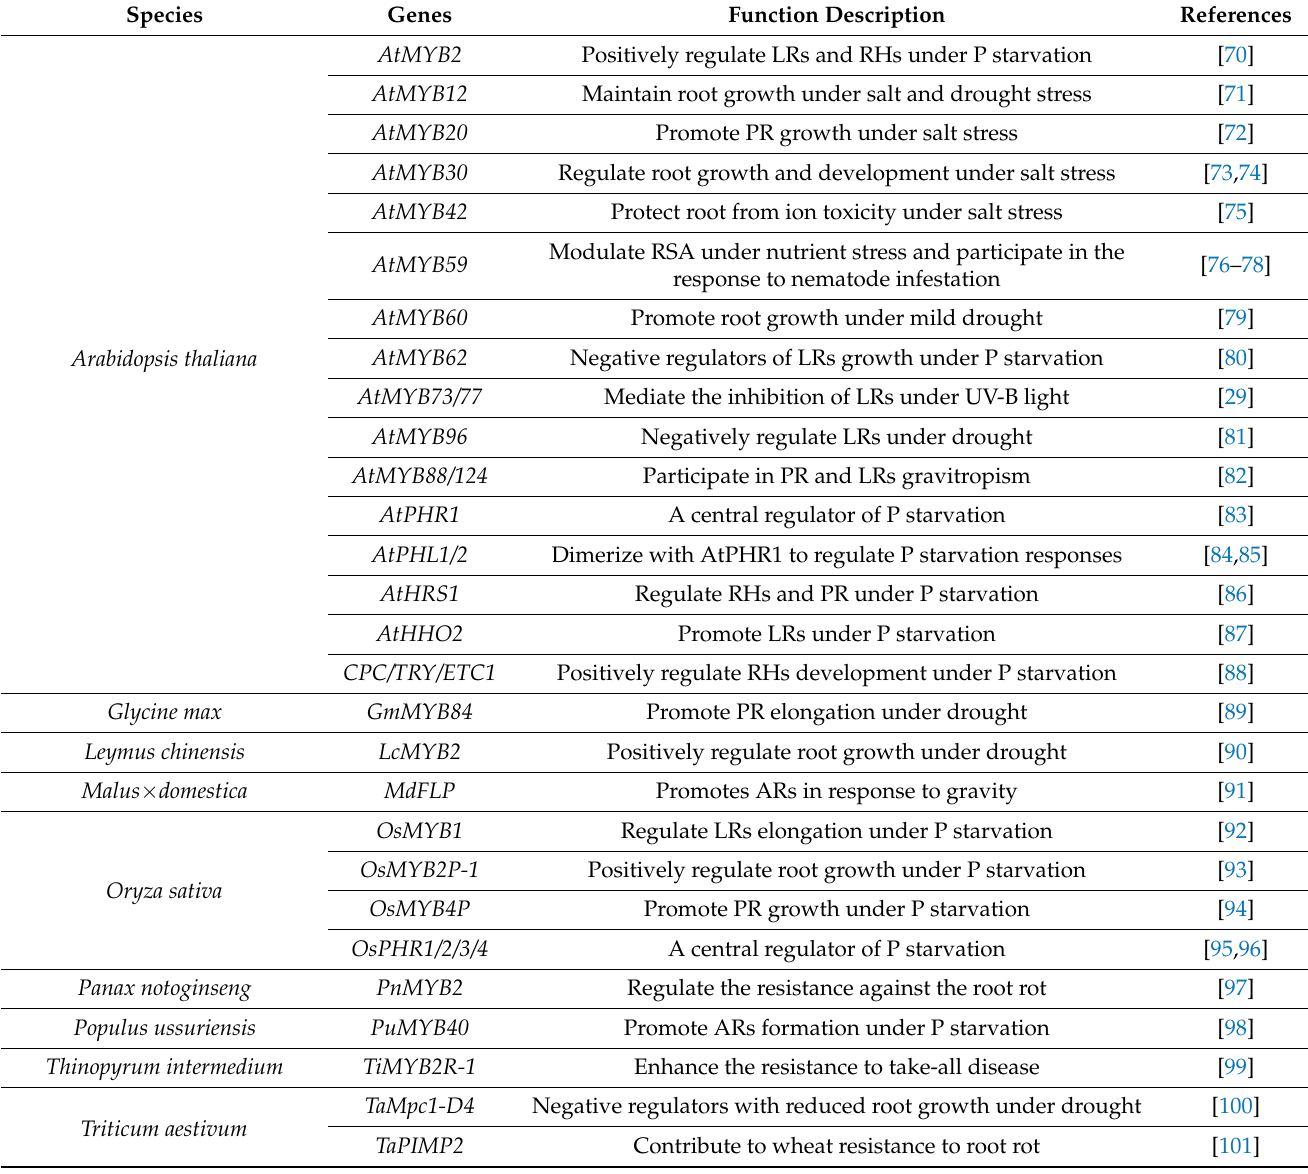
Table 1. MYB gene functions in roots under biotic and abiotic